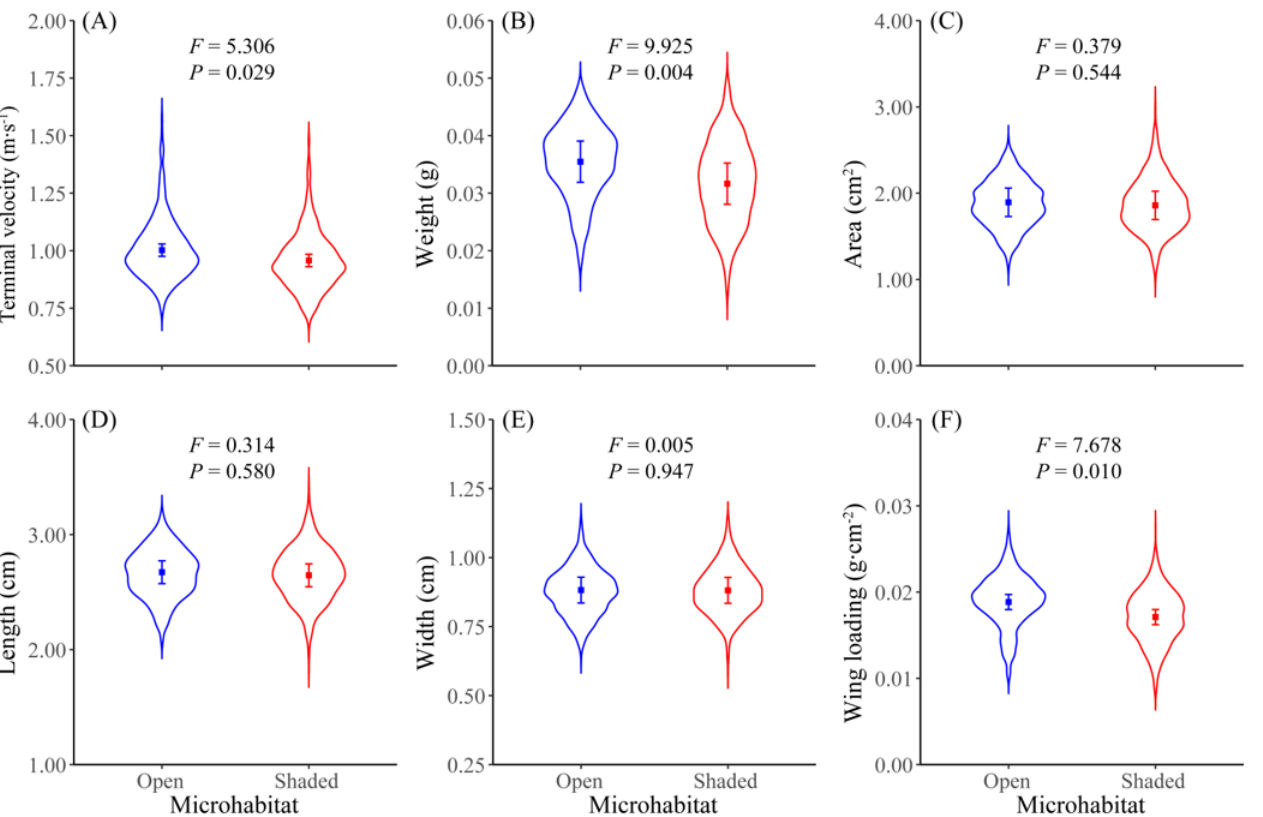
Figure 3. Dispersal potential and physical properties of Acer palmatum samaras in response to different maternal microhabitat light conditions. The dispersal potential is represented by ( A ) terminal velocity of descent, and the physical properties are ( B ) weight, ( C ) area, ( D ) length, ( E ) width and ( F ) wing loading. The violin plots describe the distributions of original data, and the associated mean (presented as points) and 95% confidential interval of the mean (presented as error bars) are obtained from linear mixed models in which microhabitat type was the fixed factor, and site and tree were the random factors. F and p values are calculated from F -statistics for the linear mixed model using a type III sum of squares with Satterthwaite’s method.